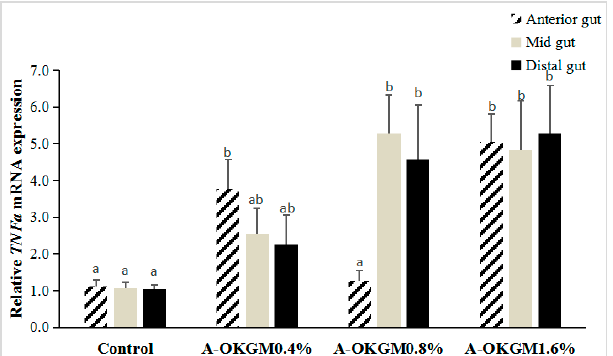
Figure 2. Effects of A-OKGM on TNF α expression in the anterior, mid- and distal gut of Schizothorax prenanti . The observed values are expressed as the mean ± S.E. a,b Means with different superscripts are significantly ( p < 0.05) different from each other.